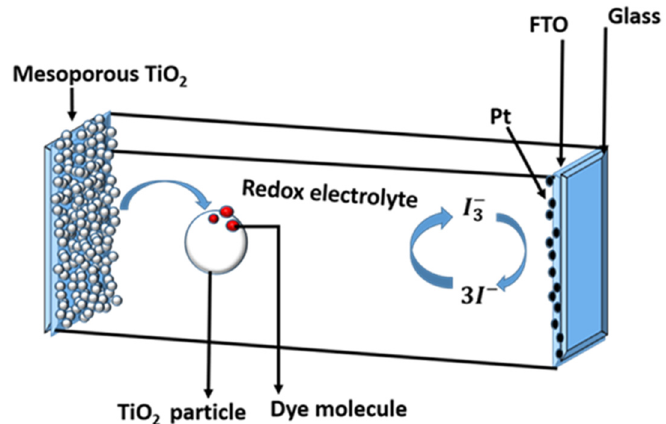
Figure 1. Schematic of the interior components of a dye-sensitized solar cell on fluorine-doped tin oxide (FTO) coated glass substrate.